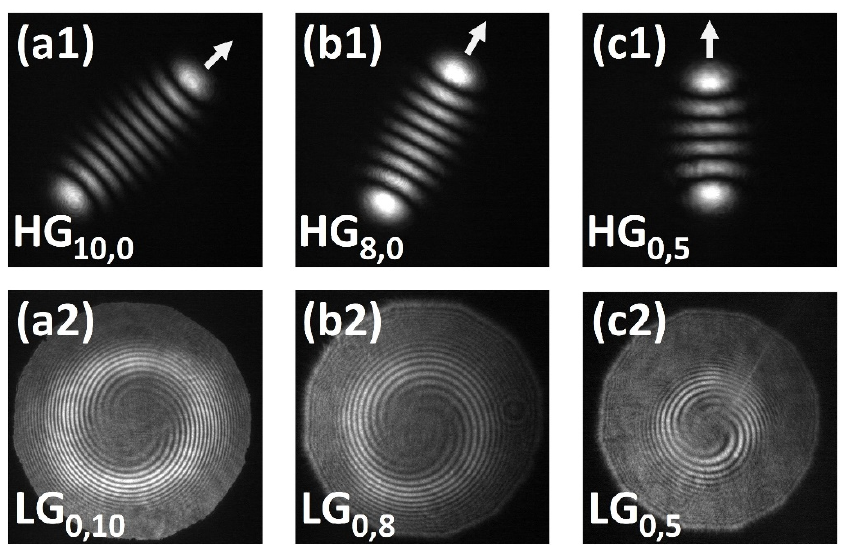
Figure 15. The generated HG and vortex beams in the dual off-axis displacement experiment with the displacement values ( dx , dy ) set as ( a1 ) and ( a2 ) (208 µ m, 207 µ m), ( b1 ) and ( b2 ) (128 µ m, 229 µ m), ( c1 ) and ( c2 ) (0 µ m, 108 µ m). Table 3. The comparison of the off-axis displacements (𝑑𝑥,𝑑𝑦) in the simulation and experiment. Off-Axis